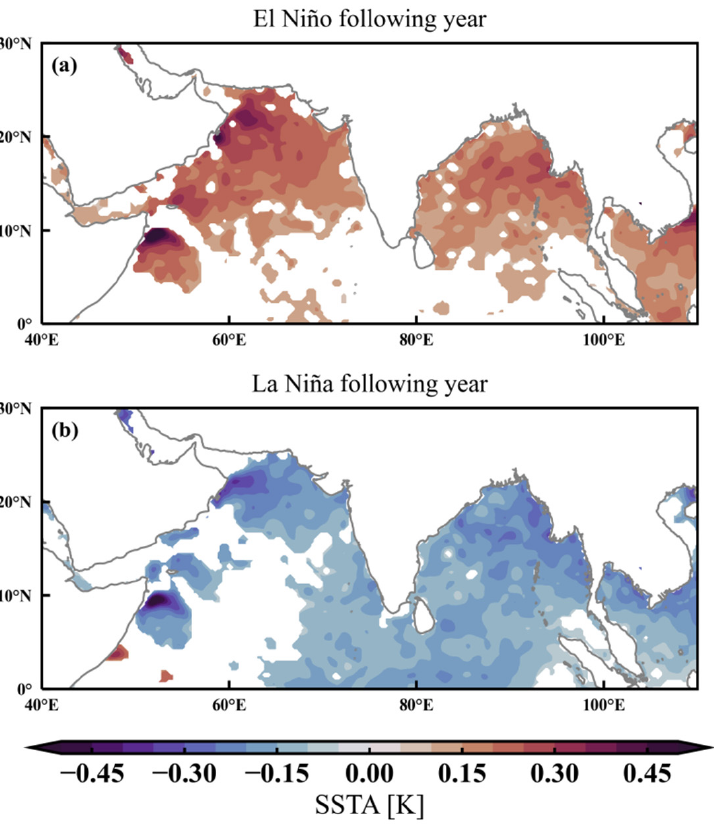
Figure 6. Indian Ocean SSTA in the summer following El Niño and La Niña (shading, unit: K) ( a ) El Niño based on ERA5, ( b ) La Niña based on ERA5. The results above the 95% confidence level ( t -test) are indicated.